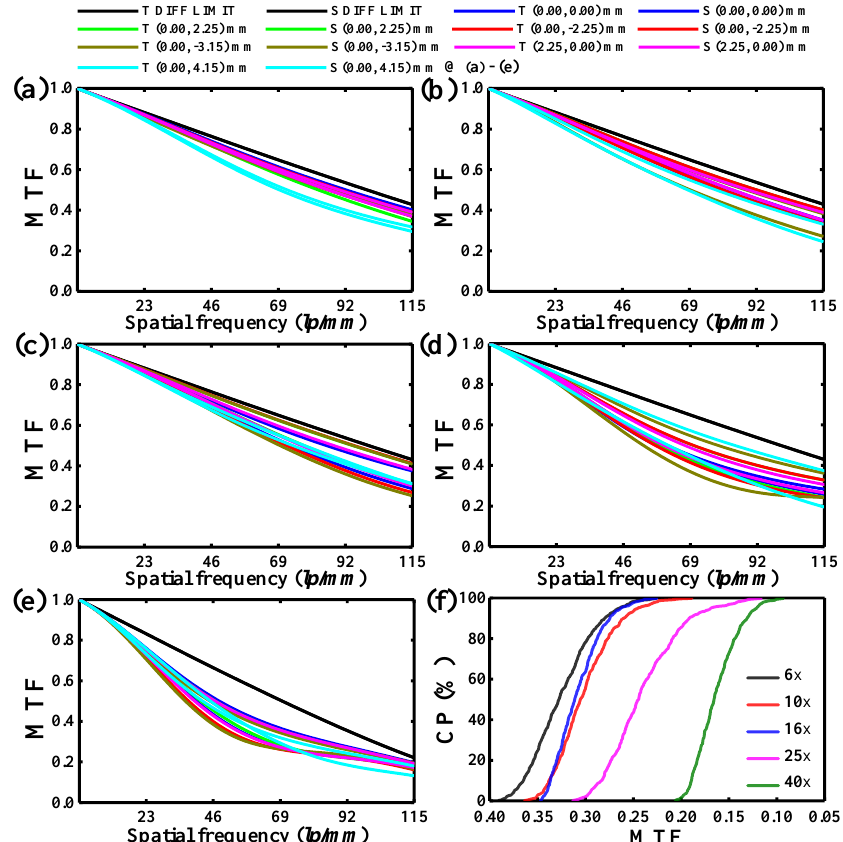
Figure 5. ( a – e ) Polychromatic diffraction modulation transfer function (MTF) curves of different magnifications: ( a ) 6 × , ( b ) 10 × , ( c ) 16 × , ( d ) 25 × , and ( e ) 40 × . ( f ) The cumulative probability (CP) functions of samples dependent on the MTFs with different magnifications.